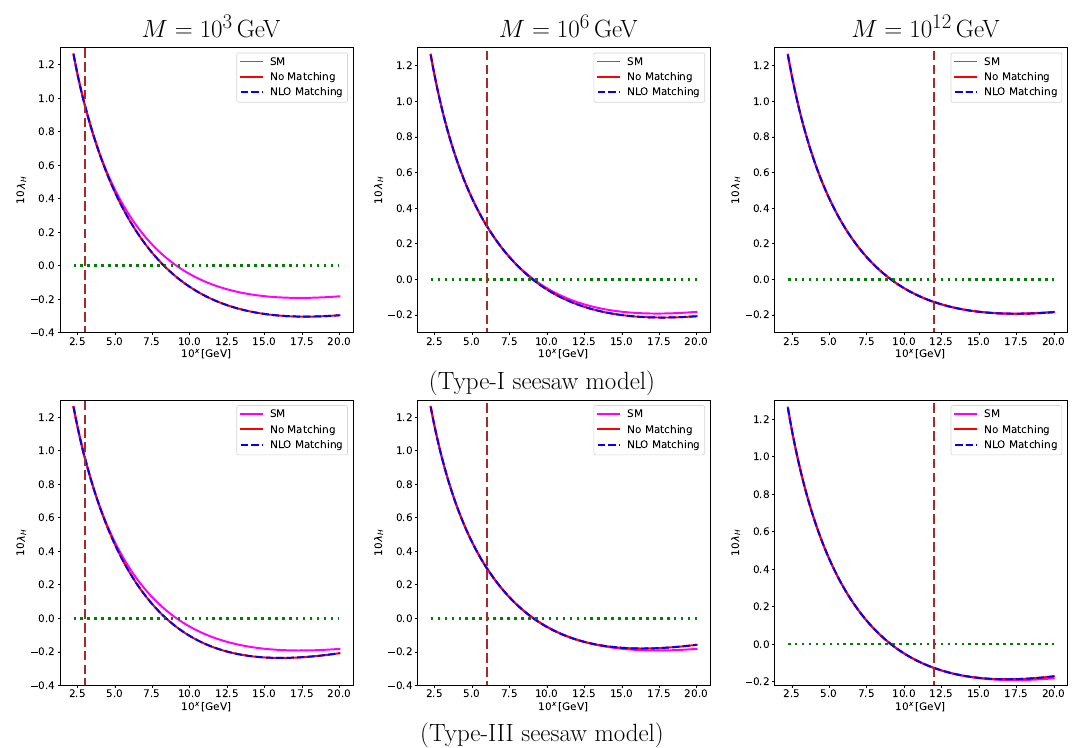
Figure 6 . Same as figure 5 but for the running of λ H in the type-I (first row) and -III (second row) seesaw models. We also introduce a dotted horizontal line in green for λ eyes locate when it runs to negative